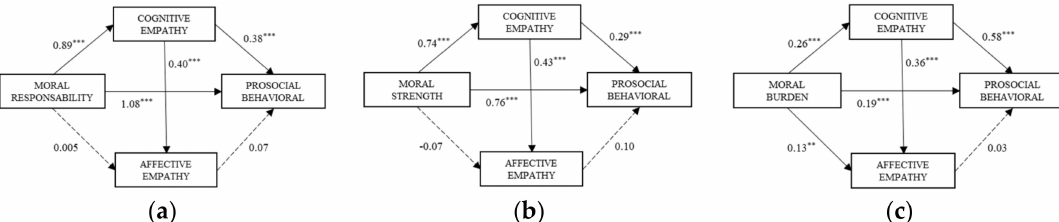
Figure 1. Statistical diagrams of the direct e ff ects in the proposed mediation models. [Note: ( a ) moral responsibility and prosocial behavior; ( b ) moral strength and prosocial behavior; ( c ) moral burden and prosocial behavior. ** p < 0.01, *** p <